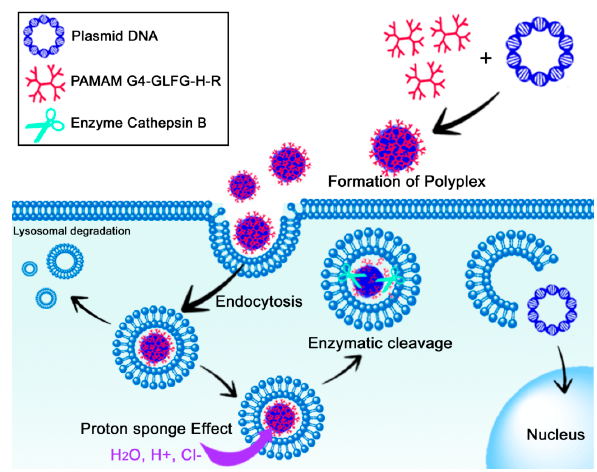
Figure 1. Illustration of endocytosis and gene delivery of poly(amidoamine) (PAMAM) generation 4 (G4)-GLFG-H-R/pDNA polyplex. GFLG: glycine-phenylalanine-leucine-glycine; H: histidine; R: arginine.